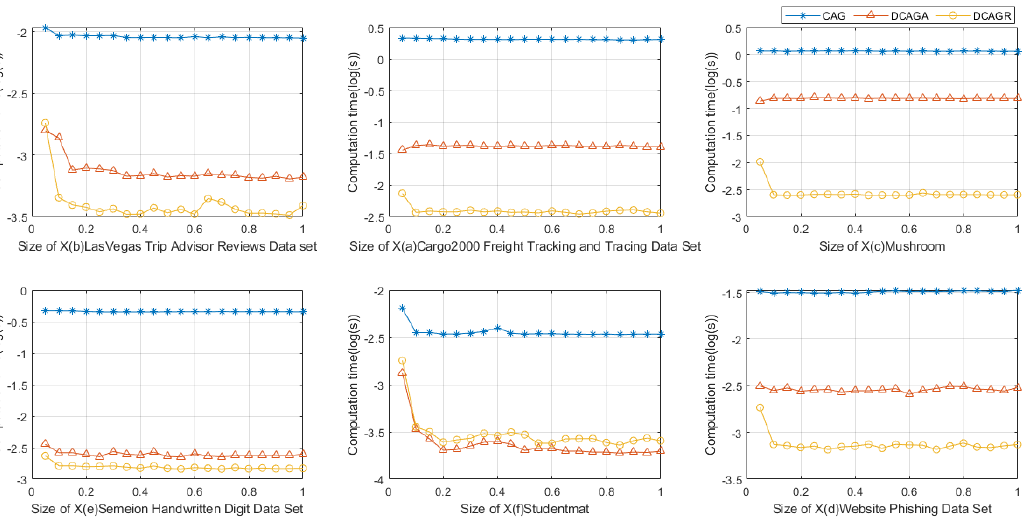
Figure 2. Comparison of the times of Algorithms 1–3 when the sizes of elements in X increase gradually.